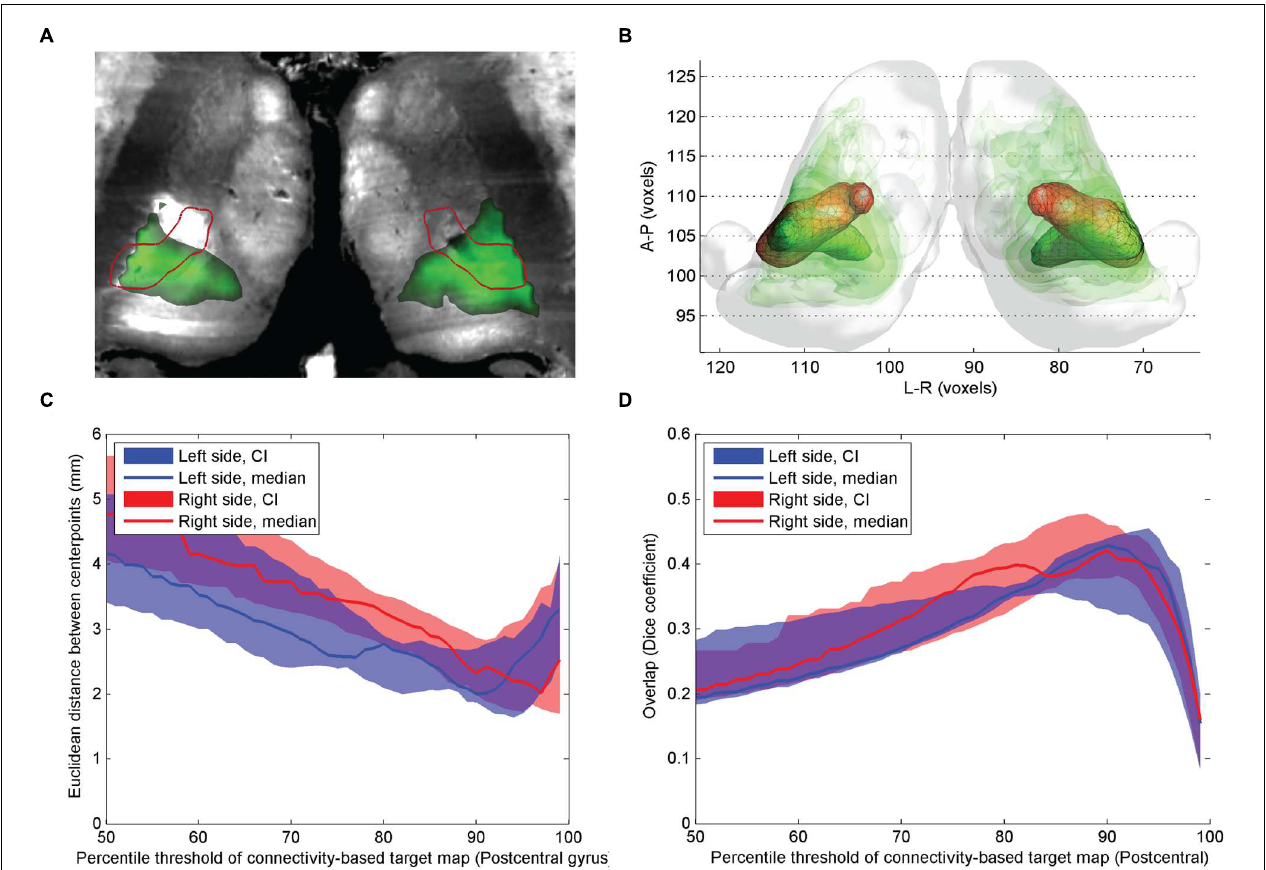
FIGURE 3 | Comparison of atlas based VPL p nucleus and CBT using postcentral gyrus connections. (A) Cross-sectional image derived from histological sections, in standard space (Big Brain Atlas, Amunts et al., 2013) with VPL p overlaid (red outlines) and the CBT from the postcentral gyrus (green color scale) ; (B) 3D visualization of the CBT and atlas targets: connectivity-based targets were visualized in green color with different opacities reflecting to the summed probability across the study population (50–95th percentile range) while the VPL p was depicted in red 3D mesh ; (C) Euclidian distance of the center-of-gravity of the CBT to the atlas based target: dependency on the applied threshold values; (D) volumetric overlap with atlas based targets: dependency on the applied